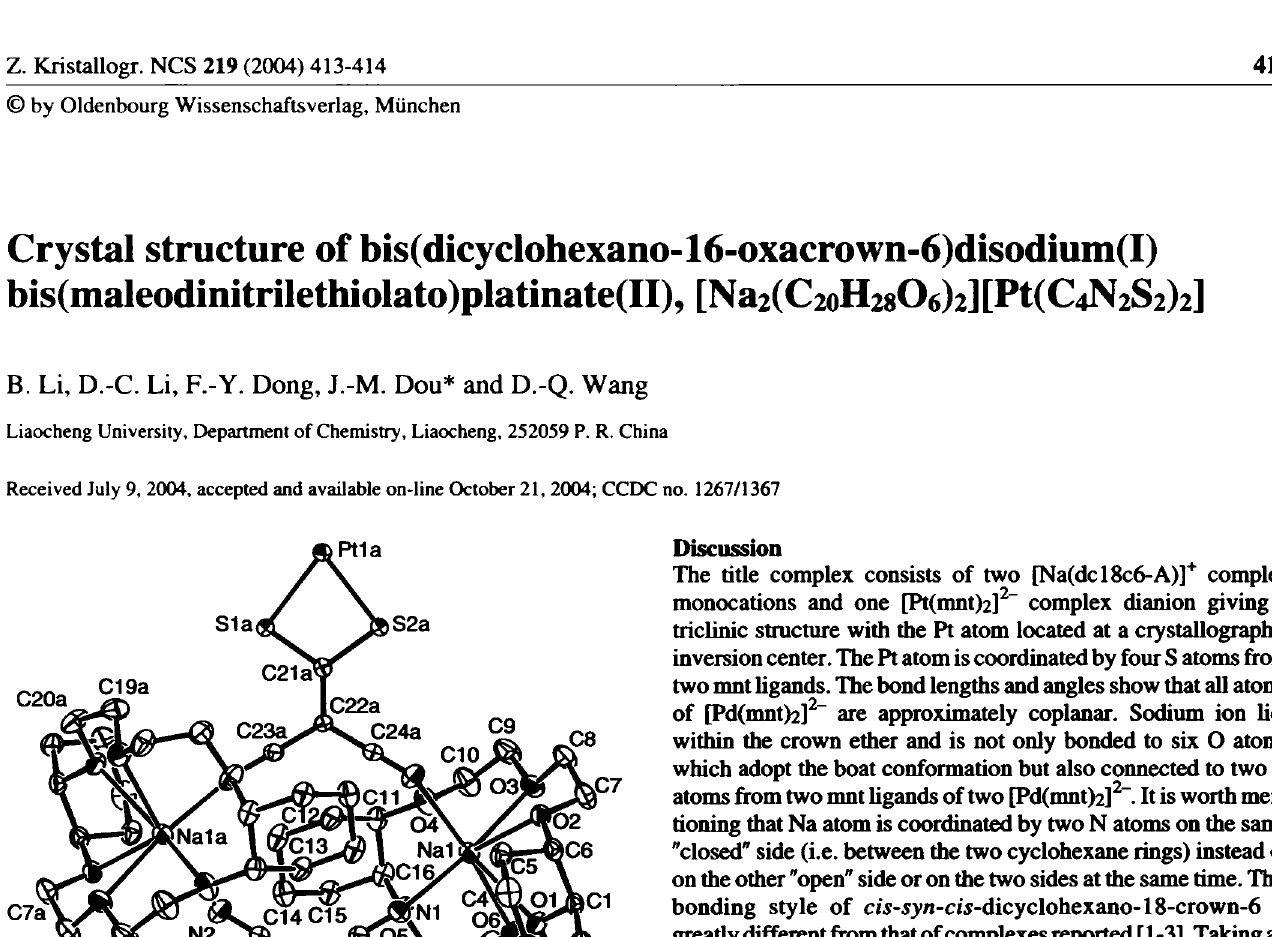
Table 1. Data collection and handling.